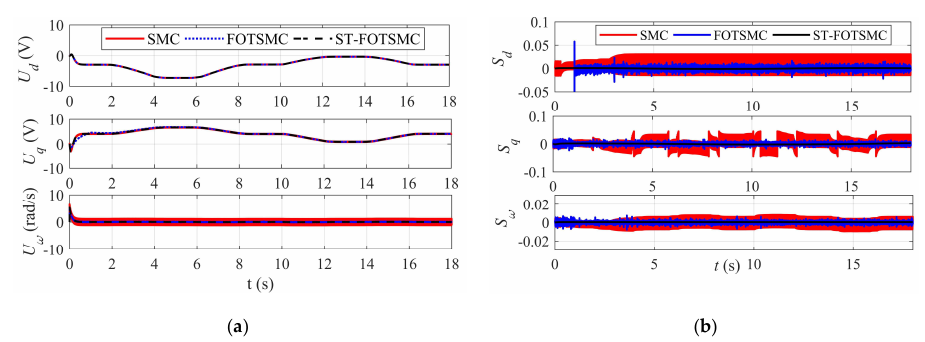
Figure 8. ( a ) Control inputs comparison; ( b ) sliding surfaces comparison for rotor side control.